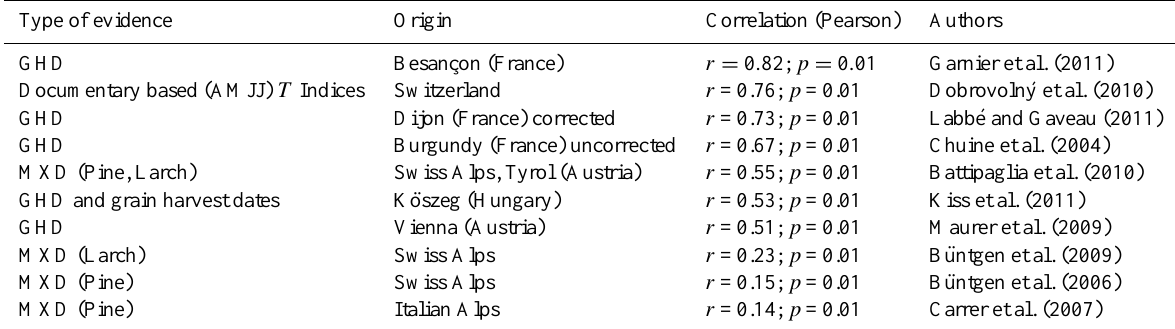
Table 1. Overall Pearson correlations between Swiss GHD and other climate proxy